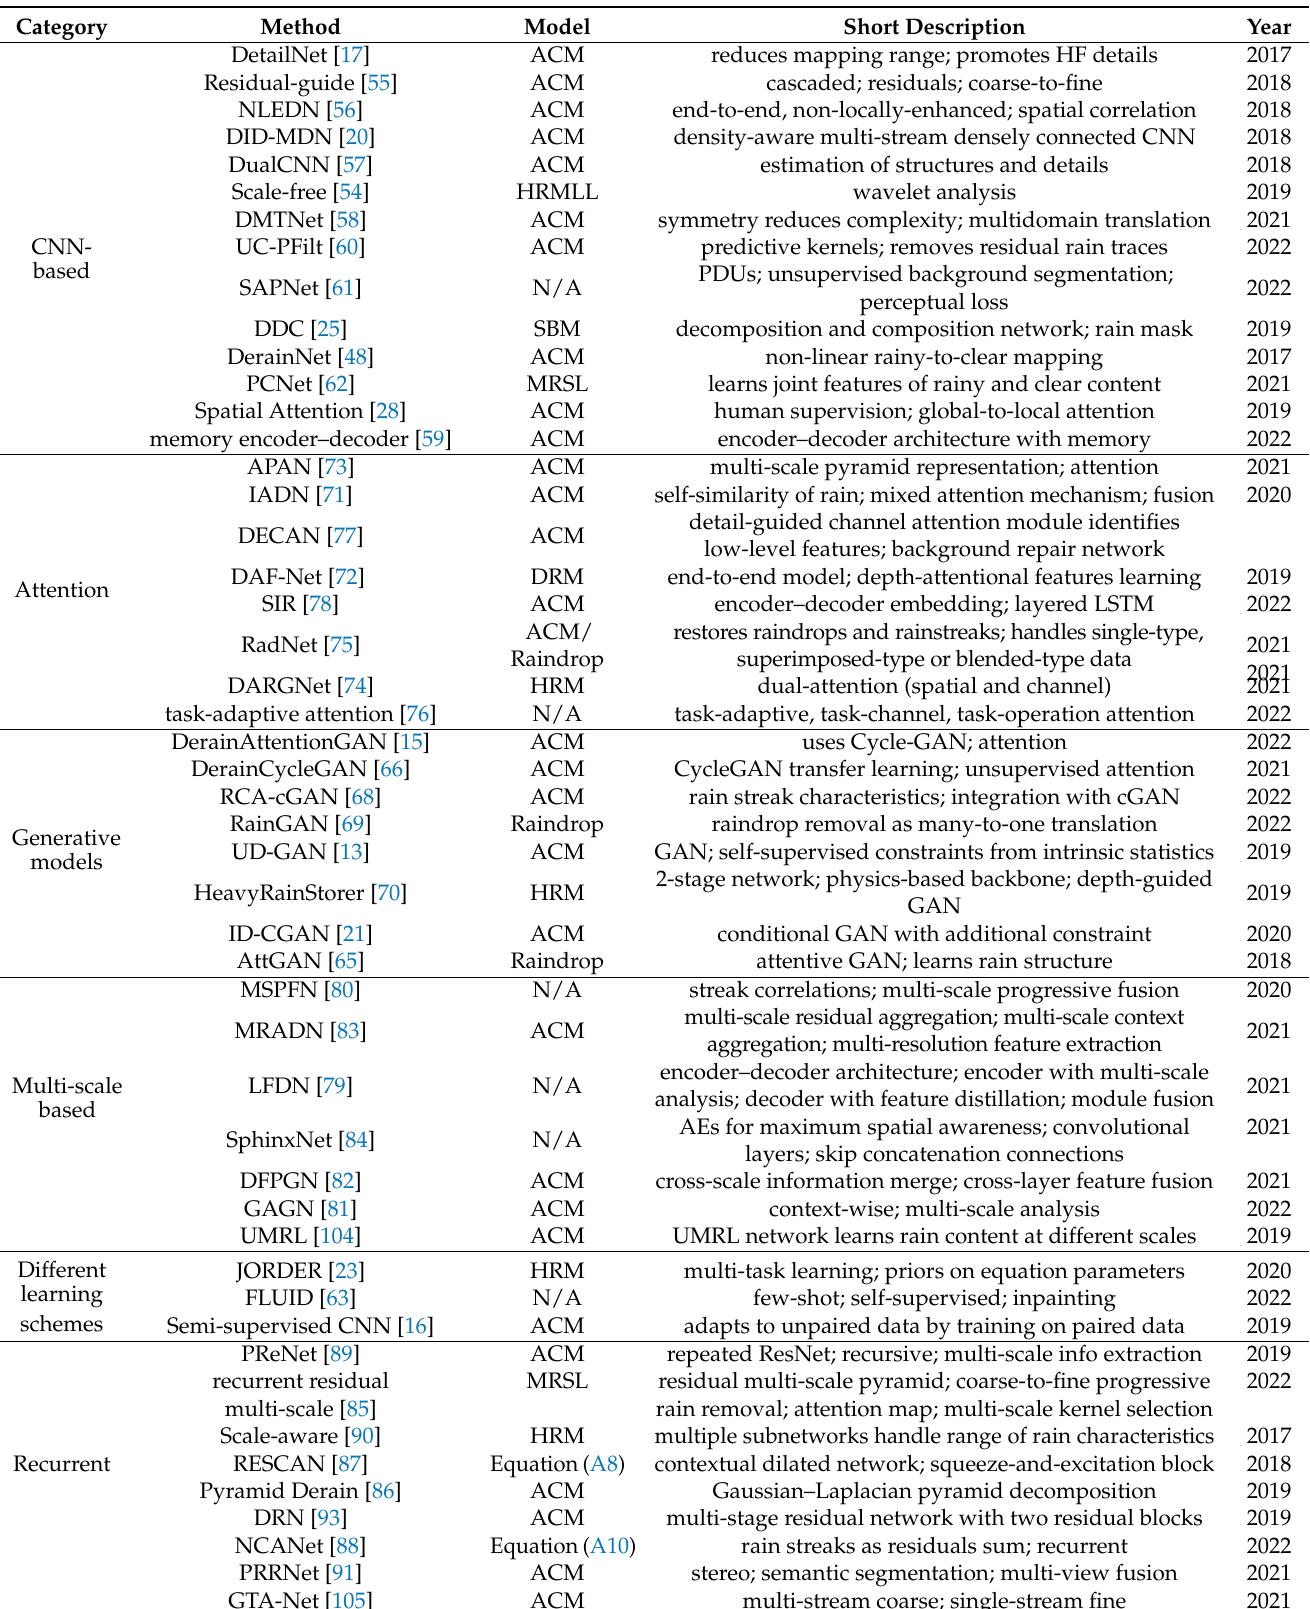
Table 4. Listing of surveyed research